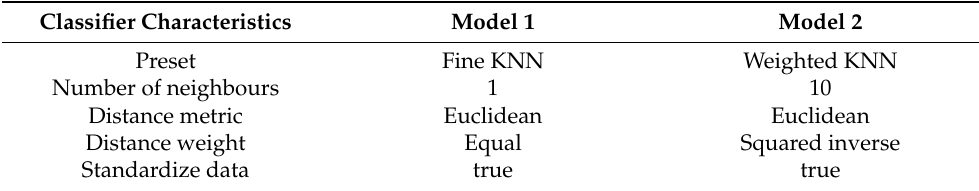
Table 3. Characteristics of KNN classification